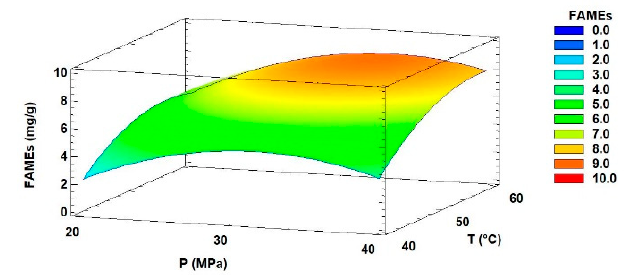
Figure 5. Response surface plot showing combined effects of pressure and temperature on FAMEs content from I. galbana . All extractions were done with 8% co-solvent (ethanol, v/v).